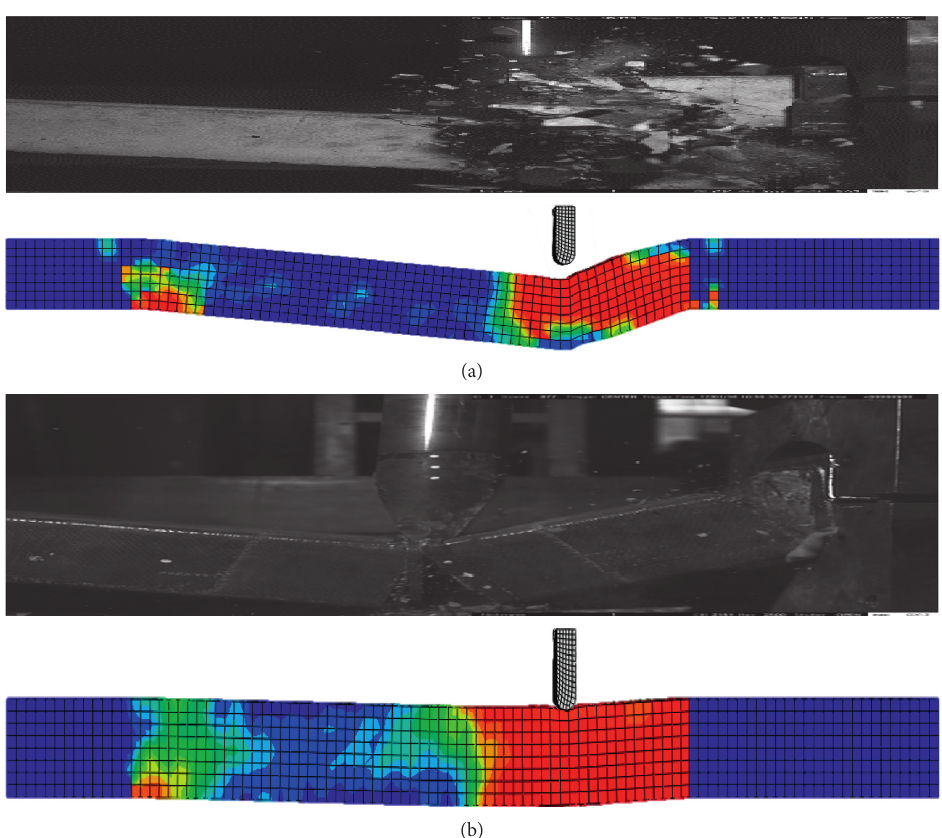
Figure 9: Crack patterns and failure modes from simulation. (a) Unstrengthened specimen. (b) Strengthen